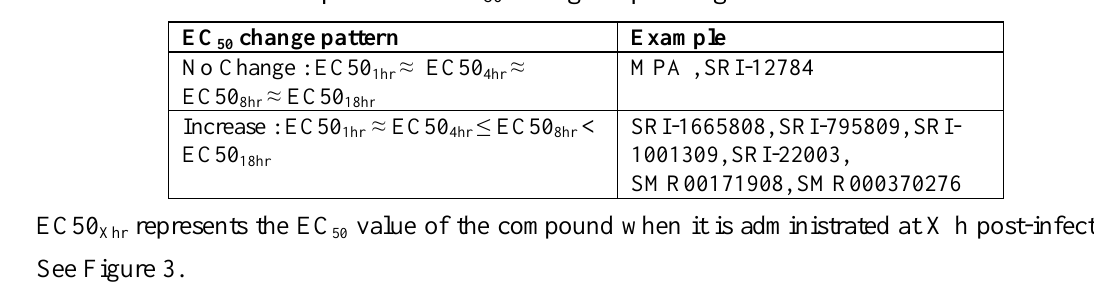
Table 2. The pattern of EC